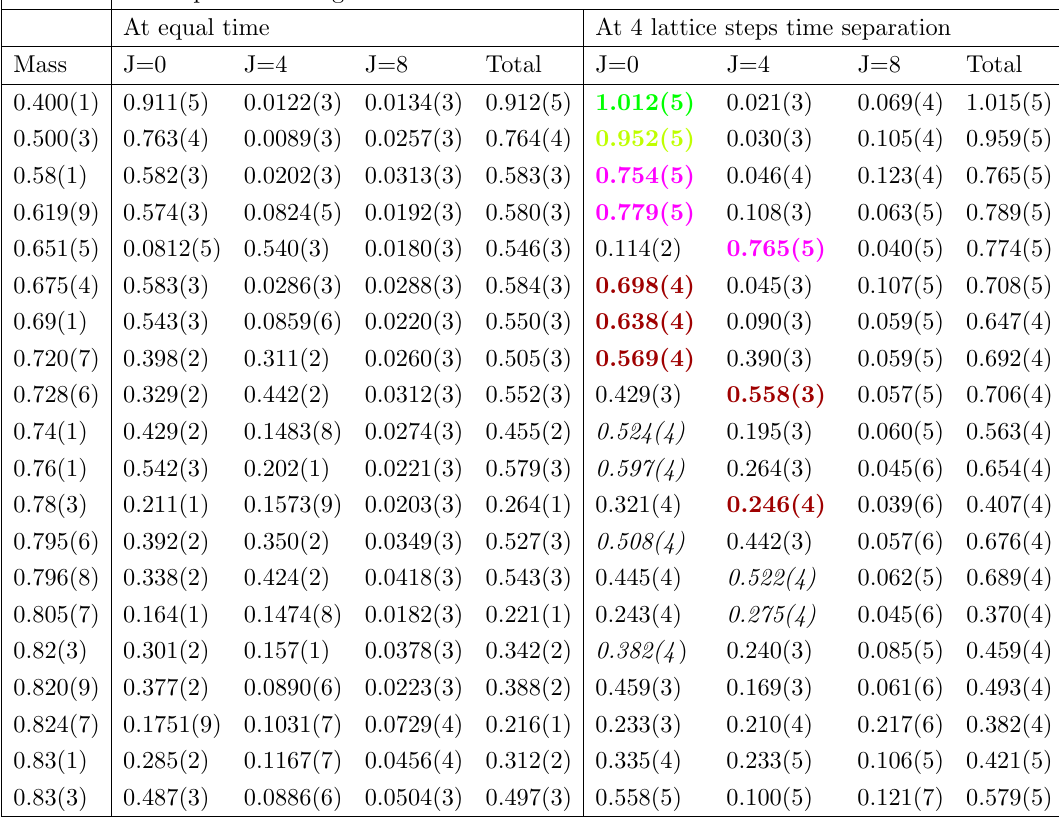
Table 14. Masses from glueballs in A 2 , C = (cid:0) representations using conventional operators and overlaps with AR